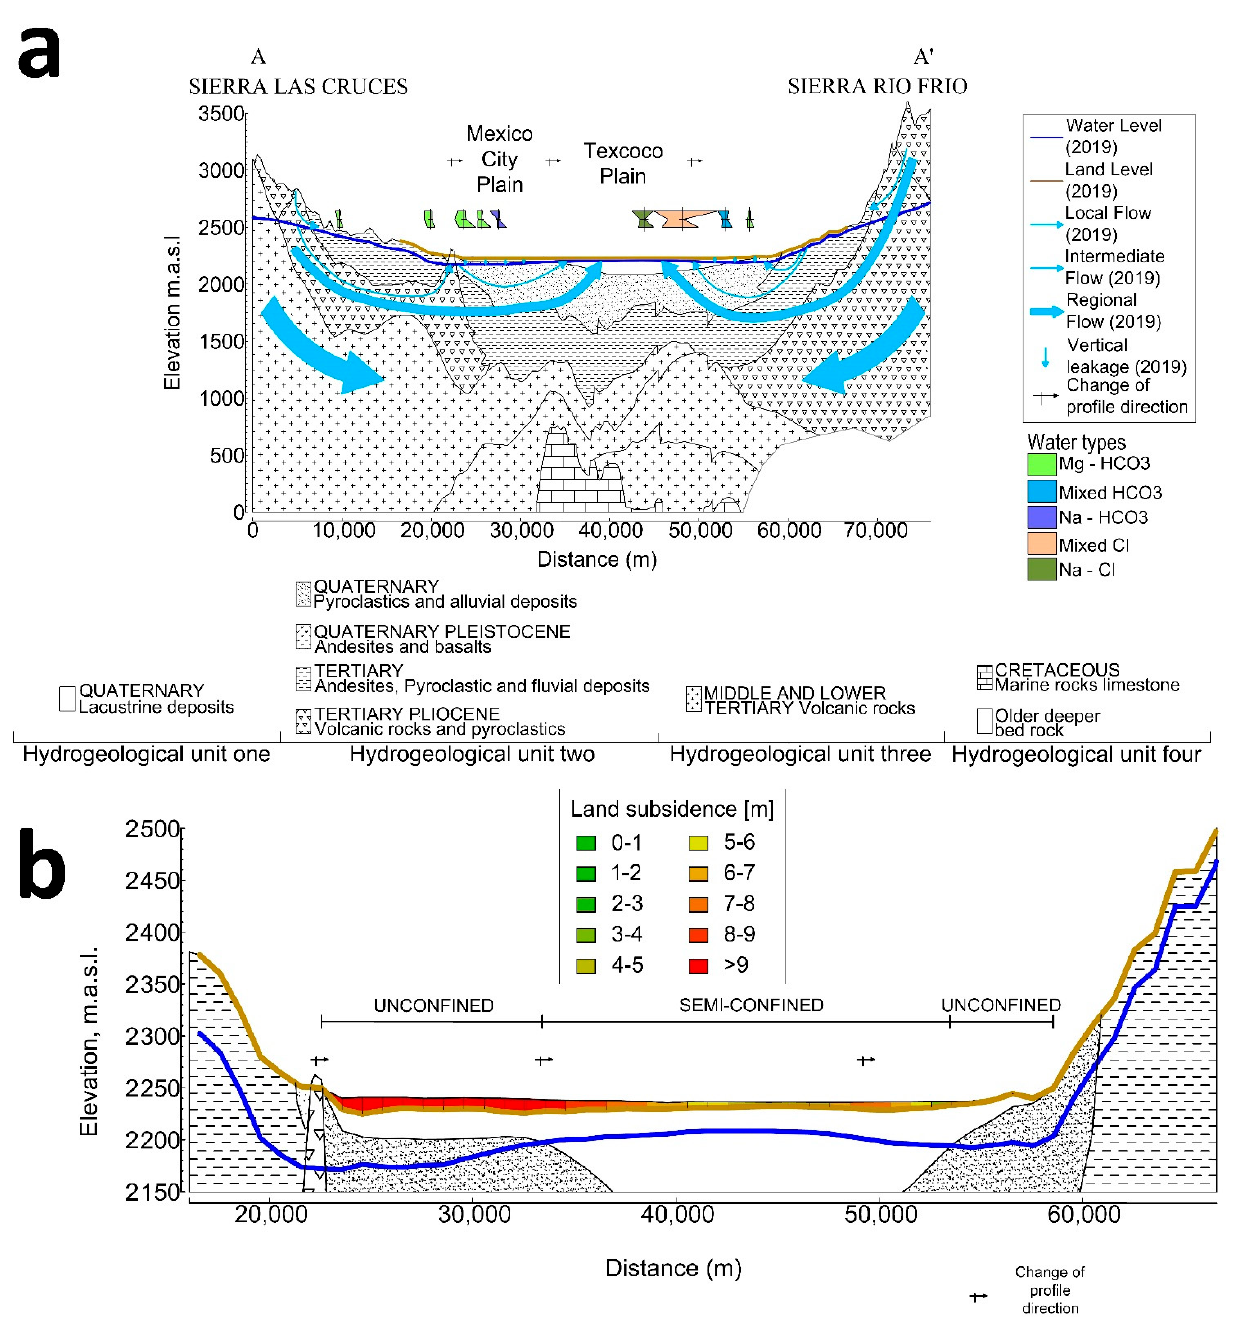
Figure 13. Hydrogeological cross section; location is shown in Figure 4 as CC’-AA’. ( a ) General groundwater flow direction and groundwater level; geochemical water types; ( b ) land subsidence in the zoomed area (between 20,000 and 60,000 m of distance), water level and land level, 2019.